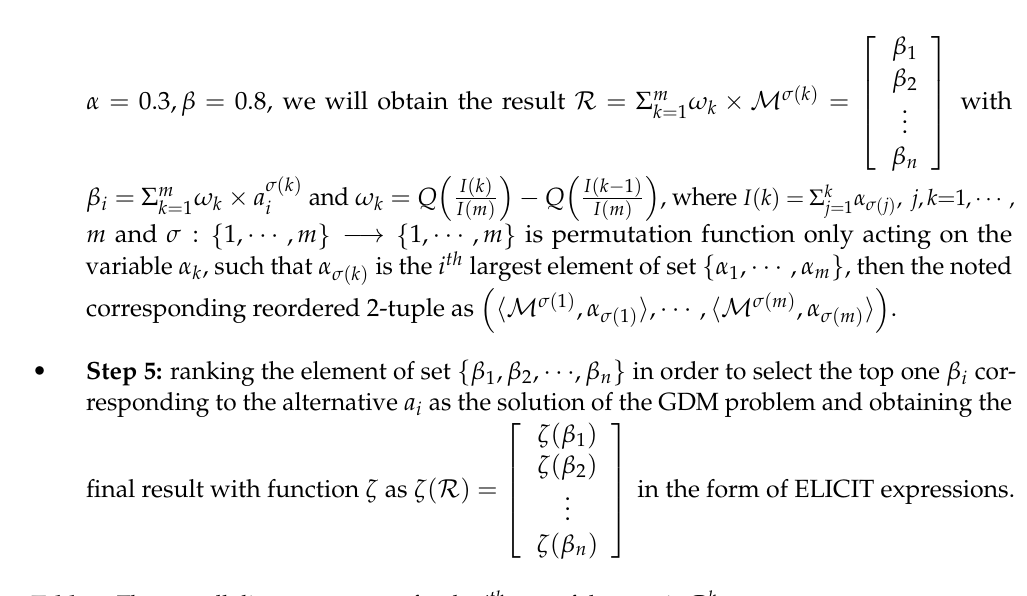
Table 1. The overall distance measure for the i th row of the matrix P k .